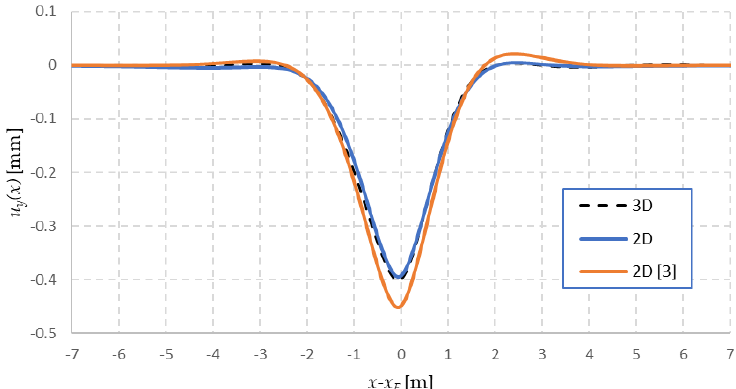
Figure 17. Steady-state vertical displacement of the rail: v = 100 m/s. Comparison of the model proposed in this paper, the model from [3] and the 3D FE model.